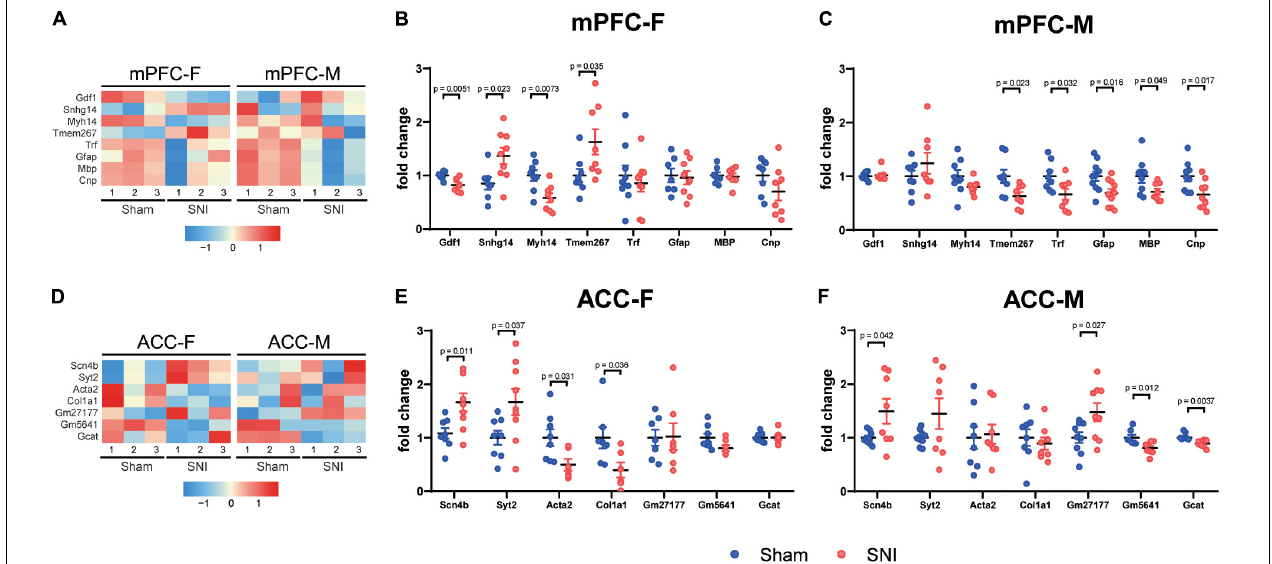
FIGURE 4 | Quantitative PCR validation of the DEGs between the sham and the SNI groups in the mPFC and the ACC of mice of different sexes. Heatmaps showing relative expression levels of the selected upregulated and downregulated DEGs in the mPFC (A) and the ACC (D) of female and male mice, comparing the sham versus SNI groups. mPFC-F, the mPFC of female mice; mPFC-M, the mPFC of male mice; ACC-F, the ACC of female mice; ACC-M, the ACC of male mice. Color scales represent standardized rlog-transformed values across samples. qPCR validation results of the selected upregulated and downregulated transcripts in the mPFC (B,C) and ACC (E,F) . N = 6–9 mice per group. Data are analyzed by unpaired Student’s t -test, and presented as mean ±